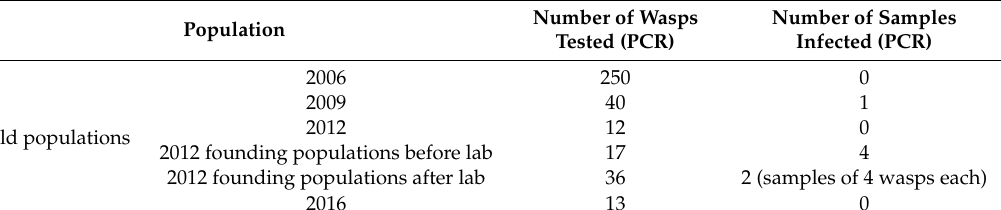
Table 2. Number of virus positive samples of wild populations.